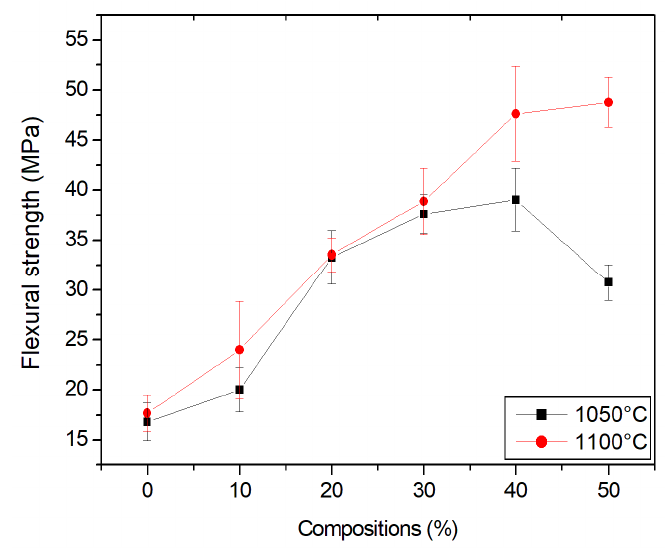
Figure 12. Ceramic material flexural strength.